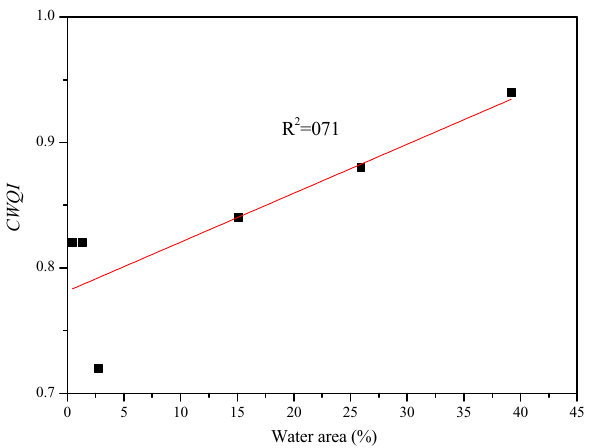
Figure 6. Correlation between the water area and CWQI for the catchments with the PAHs as the main pollution